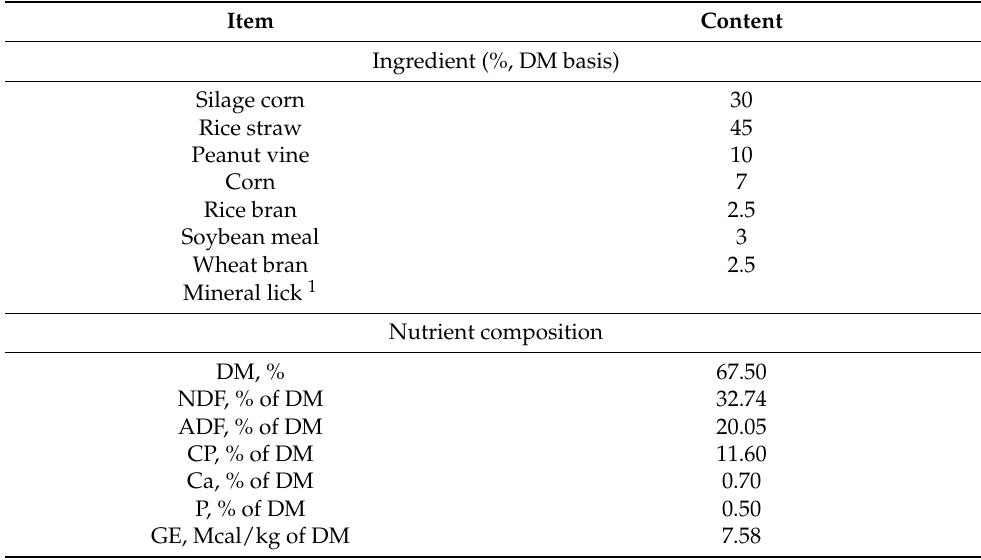
Table 1. Feed ingredients and composition of the diets fed to experimental buffalo ( n =